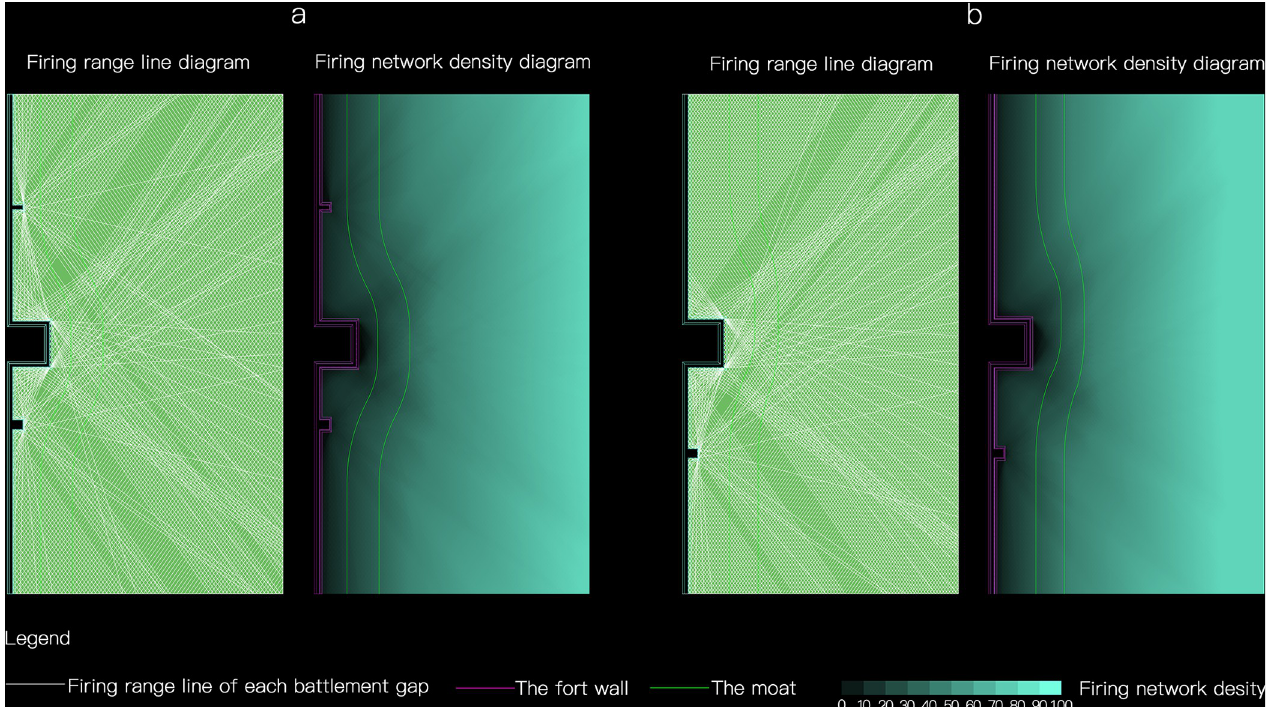
Fig 8. The simulation of firepower network of Puzhuang Suo-Fort south wall (a) and The simulation of firepower network of Puzhuang Suo-Fort east wall (b).